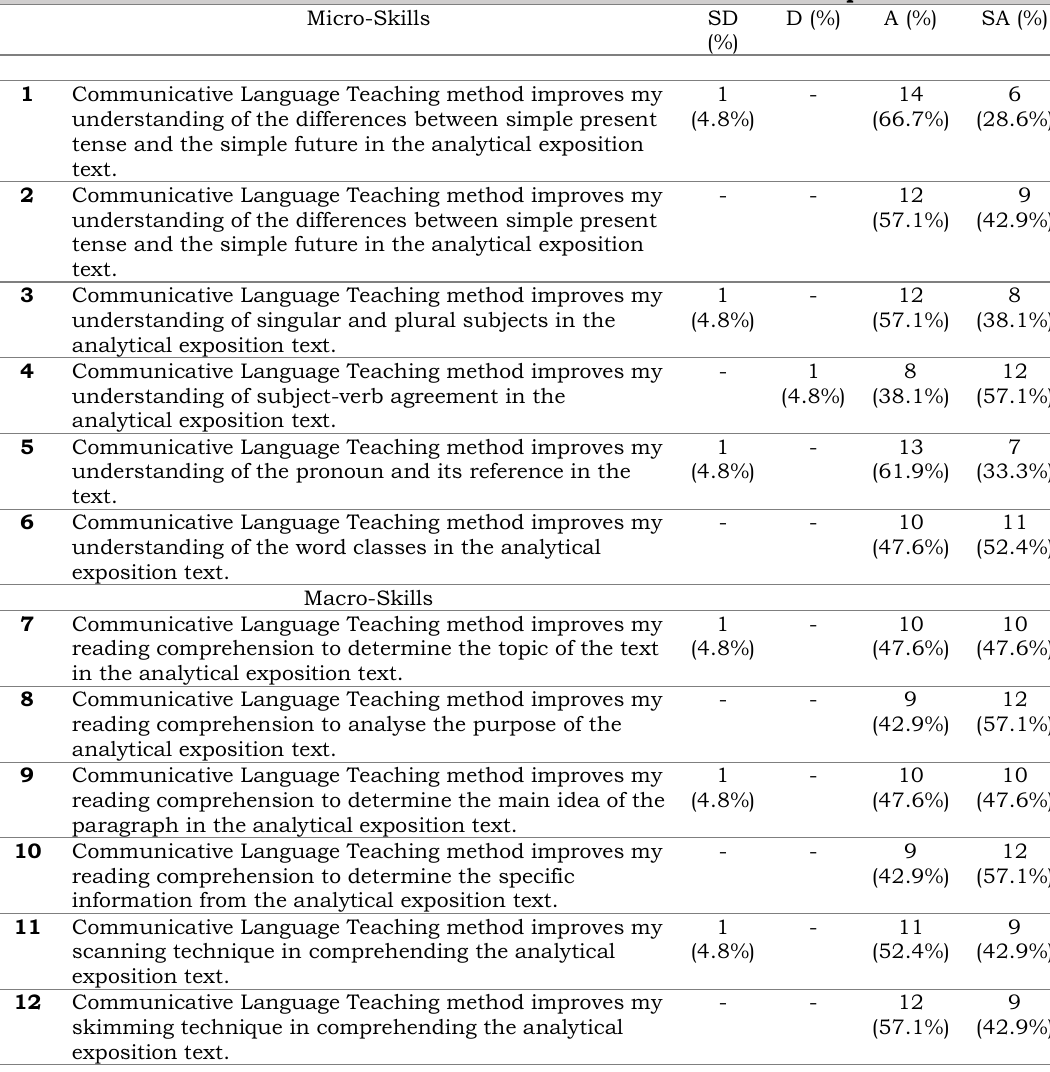
Table 2. Recapitulation of students’ micro-skills and macro-skills of reading comprehension after using CLT